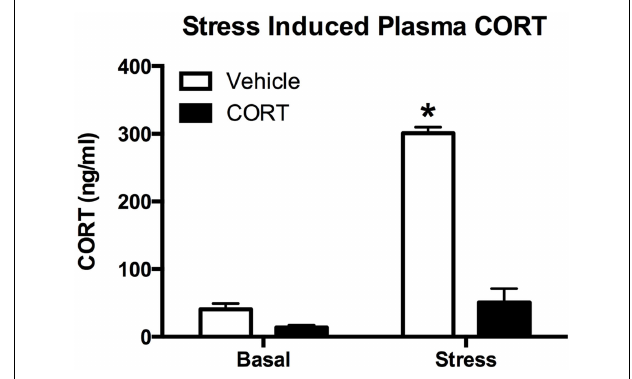
FIGURE 2 | Chronic low-dose CORT treatment blocks the normal endocrine response to stress .Treatment with CORT (25 µ g/ml) in the drinking water for 4weeks resulted in reduced CORT secretion following a 10-min forced-swim stress at ZT6, with no effect on basal plasma CORT levels. Asterisk indicates statistically significant difference at the P < 0.05 level.